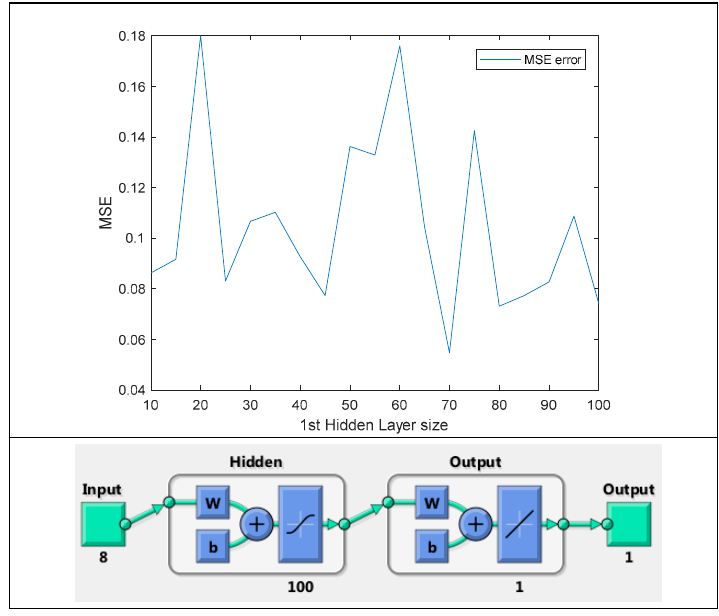
Figure 1. Architecture and graph of Mean Square Error (MSE) plot as varied for 1st layer number of neurons.